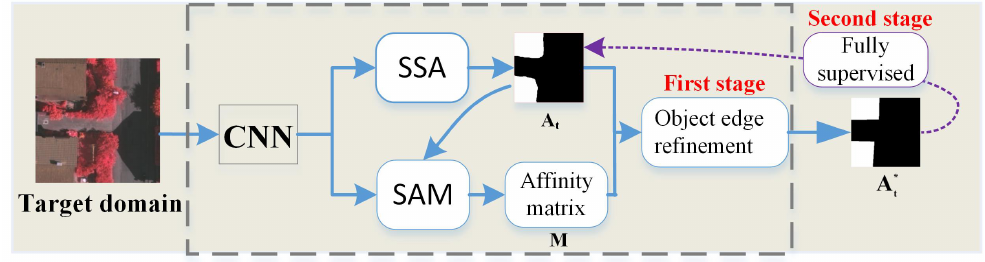
Figure 6. The overview training framework for target domain data. Algorithm 1 The pseudocode for